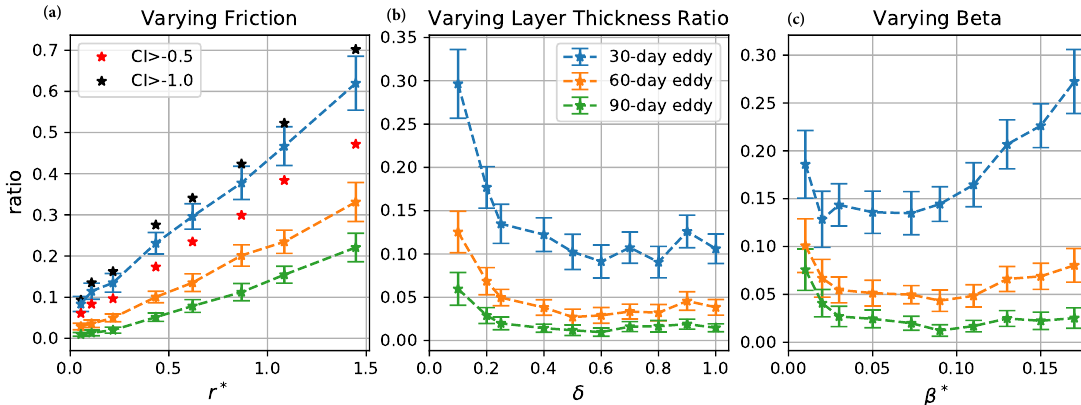
Figure 14. Ratio of meridional PV transport by the flow induced by coherent eddies to total PV transport as a function of ( a ) r ∗ , ( b ) δ , and ( c ) β ∗ . Blue, orange, and green curves correspond to the mean of the ratio for 30-, 60-, and 90-day eddies, respectively. Error bars give two times the standard error of the mean over 100 time intervals. Red and black stars in the left panel indicate the mean for 30-day eddies detected by varying the CI threshold to − 0.5 and − 1.0,